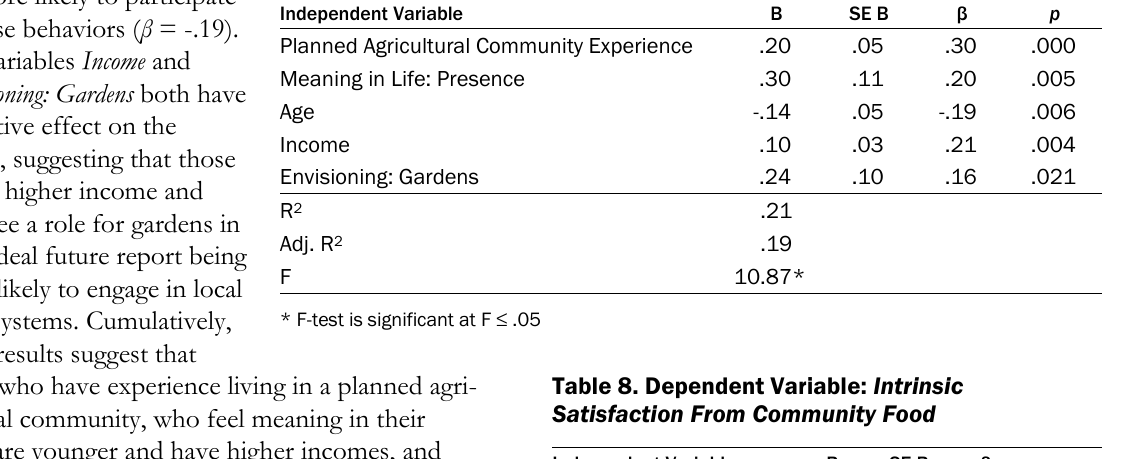
Table 7. Dependent Variable: Food Engagement